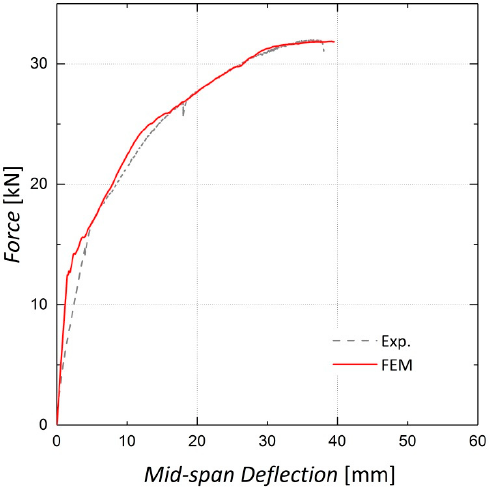
Figure 17. Finite Element analysis results for Beam 10 (pre-stressed by two Fe-SMA bars).